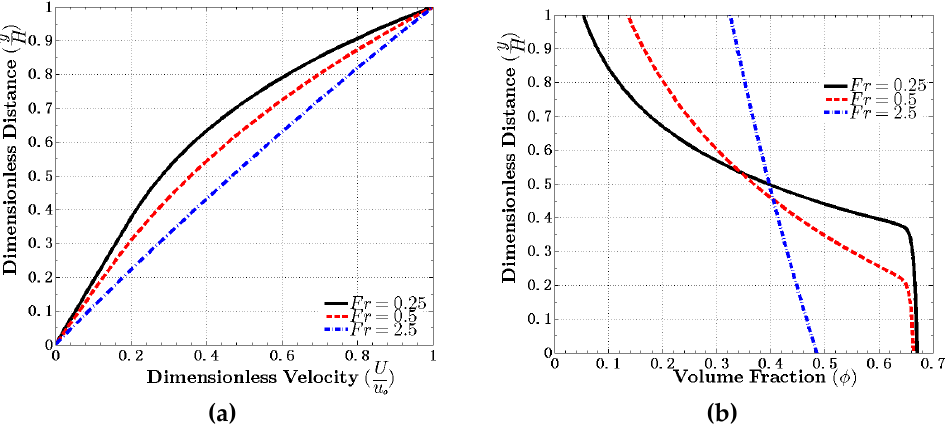
Figure 7. The effect of Fr number on the velocity profile ( a ) and the volume fraction profile ( b ), when R = 1, m = 1, ( 2 M 1 + M 2 ) = 1, B p = − 1, B r = − 10, φ c = 0.68, S = 100, N = 0.4. Fluids 2018 , 3 , x FOR PEER REVIEW